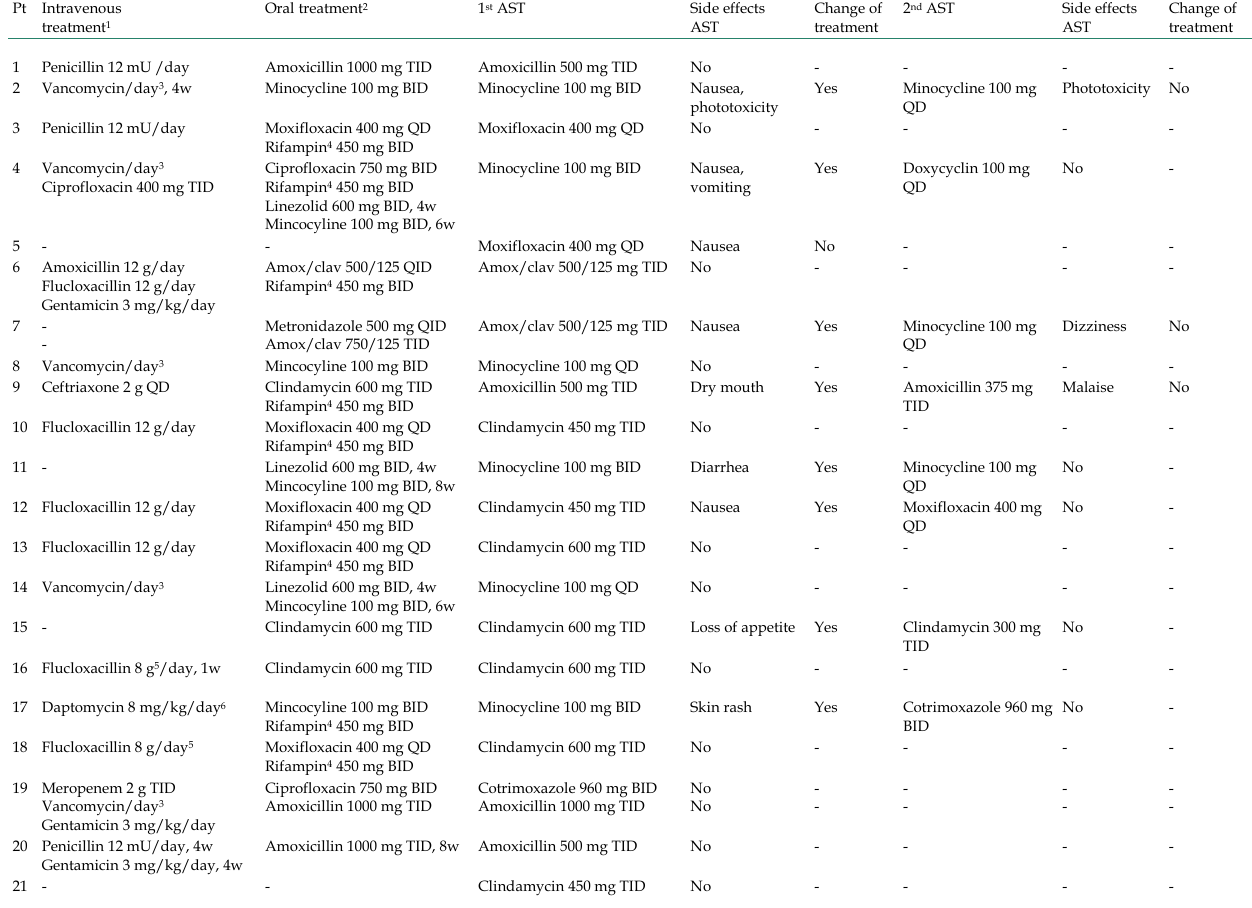
Table 2 . Overview of the initial treatment and the antibiotic suppressive therapy (AST) per patient, the reported side effects and subsequent intervention. Pt Intravenous Oral treatment 2 1 st AST Side effects treatment 1